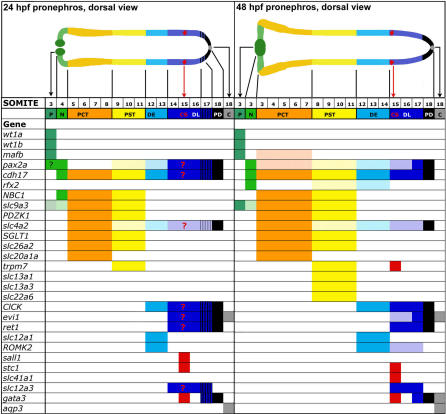
Pronephros Expression of Known Renal Genes and Solute Transporters Isolated Using Functional GenomicsThe domain of each pronephros-expressed gene was mapped along the embryonic axis according to somite boundaries, using double in situ hybridization with mhc to label the myotomes. Solid color bars indicate strong expression, light color bars indicate weak expression, and blue/black stripe bars indicate overlap in the expression domains of DL and PD markers; note that rfx2 expression at 48 hpf is discontinuous in the PST and DE domains. Schematic anatomy of the pronephros at 24 hpf (top, left) compared to 48 hpf (top, right). The cloaca (C) is not considered a segment of the pronephros, but is shown to depict the terminus of the pronephros.